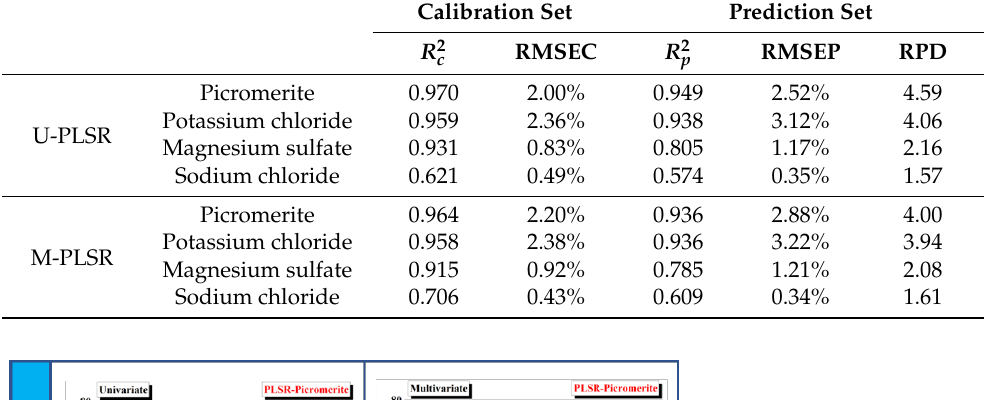
Table 5. Results of calibration and prediction sets for U-PLSR and M-PLSR models. Calibration Set Prediction Set